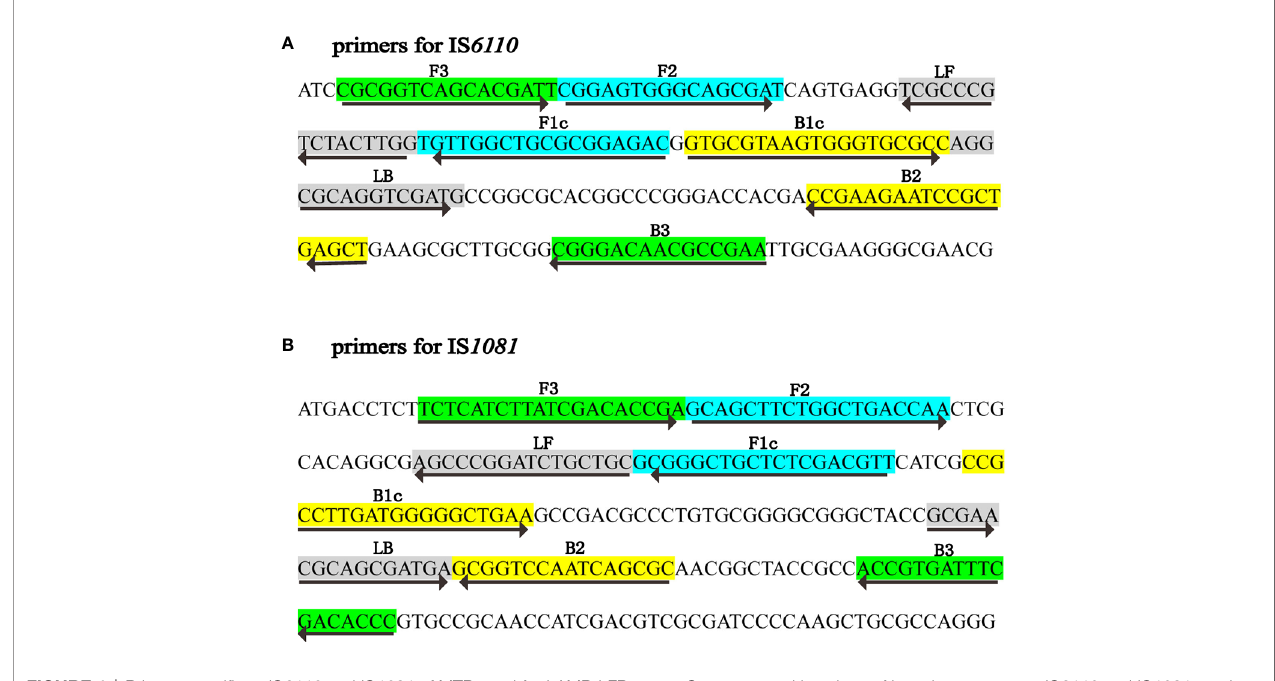
FIGURE 1 | Primers speci fi c to IS 6110 and IS 1081 of MTB used for LAMP-LFB assay. Sequence and locations of insertion sequences IS 6110 and IS 1081 used to design LAMP primers. The nucleotide sequences of IS 6110 (A) and IS 1081 (B) are shown. Primer FIP included F2 and F1c; Primer BIP included B1c and B2. The direction of arrows indicated the primer from 5 ’ to 3 ’ TABLE 1 | The sequences of primer sets used in this study.